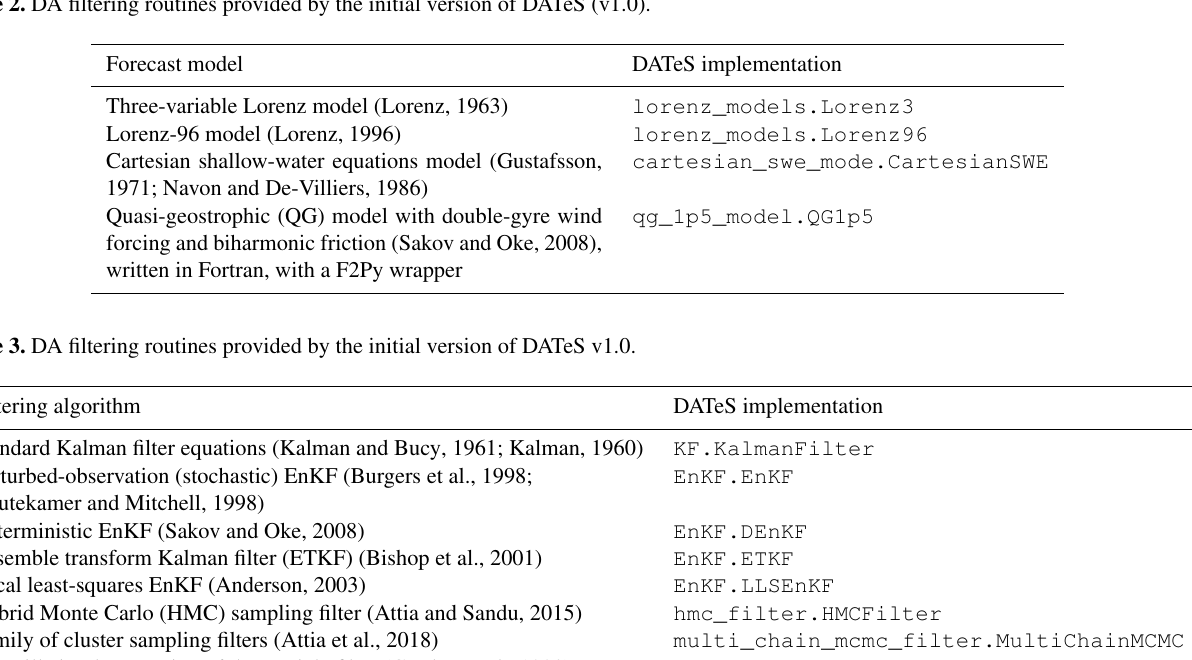
Table 2. DA filtering routines provided by the initial version of DATeS (v1.0).